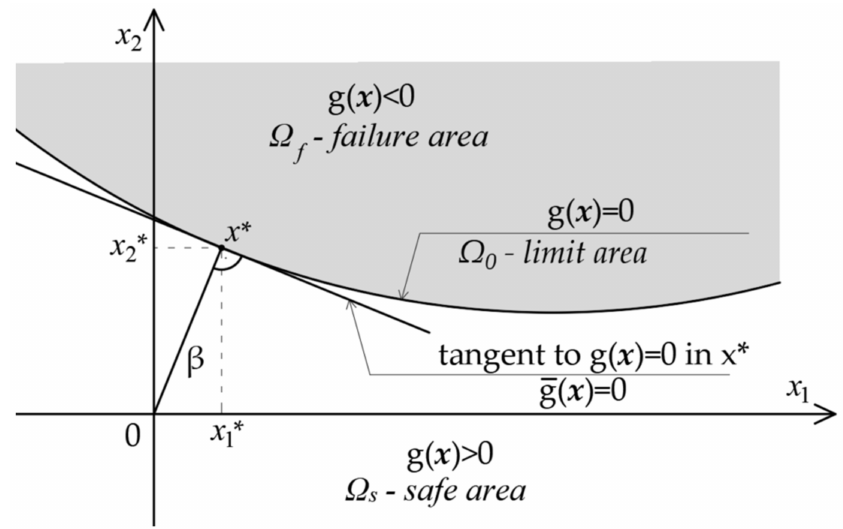
Figure 1. Non-linear, n-dimensional (for n = 2) surface of the limit state function g( x ) = 0 realization space of the basic random variables, with the marking of linearization on the surface g ( x ) of the limit state function at point x